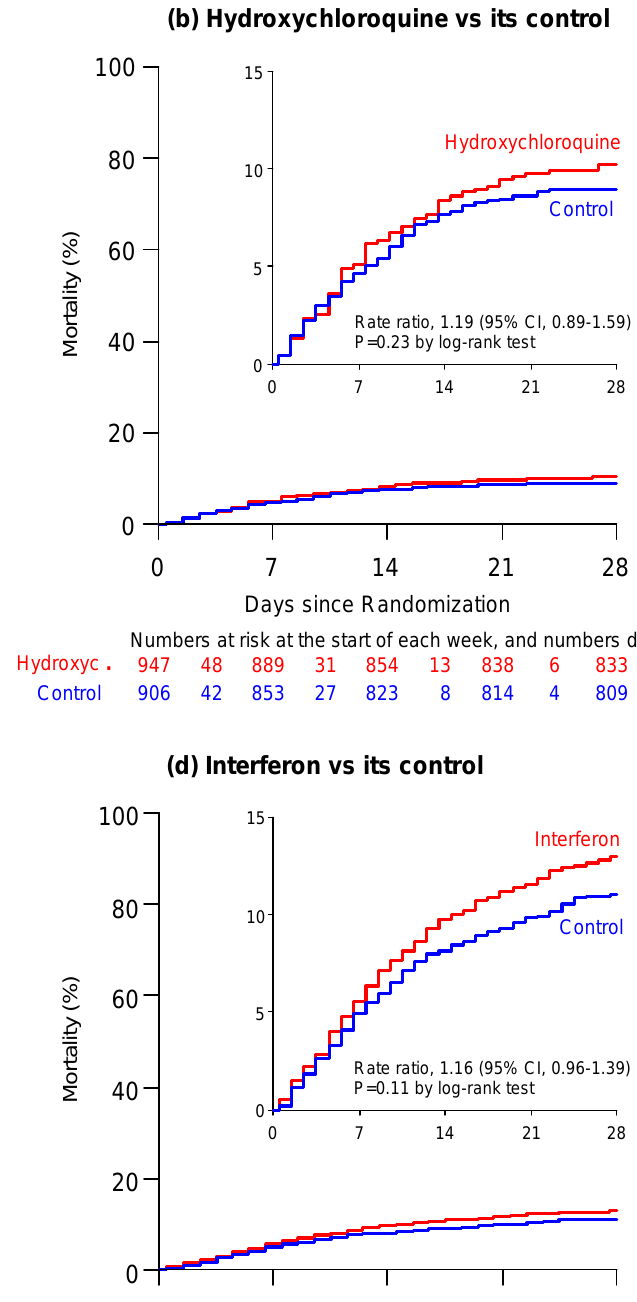
(a) Remdesivir vs its control (b) Hydroxychloroquine vs its